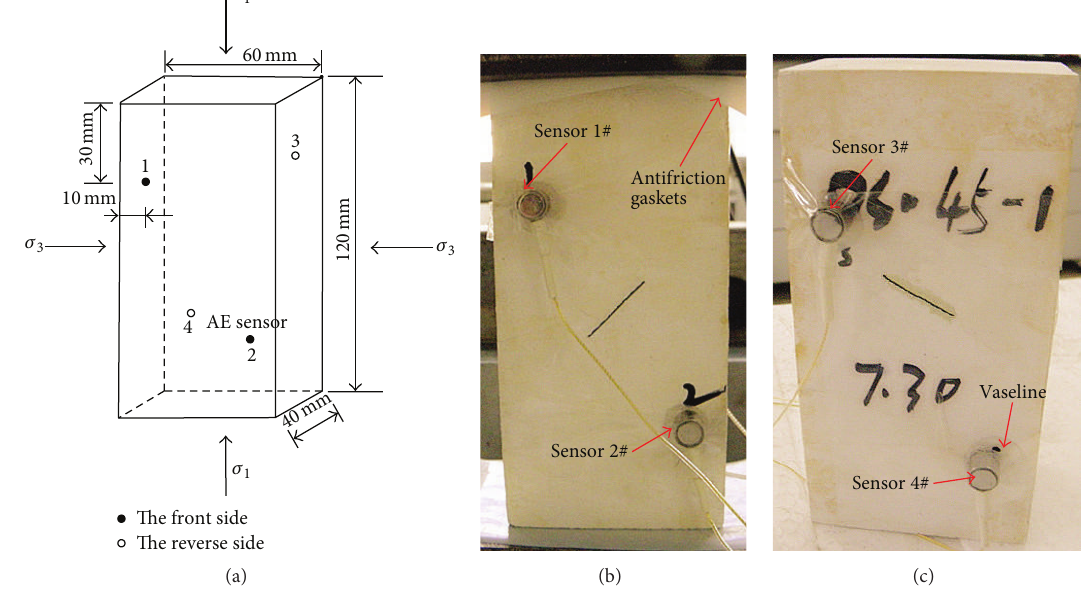
Figure 4: Layout of AE sensors on specimen. (a) The locations of all sensors. (b) Sensors 1# and 2# on the front side. (c) Sensors 3# and 4# on the reverse side.